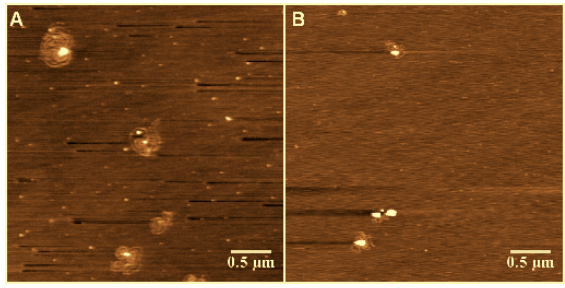
Figure 4. DNA structures in solution of ( A ) 0.01 mM spermine and ( B ) 0.5 mM As + .